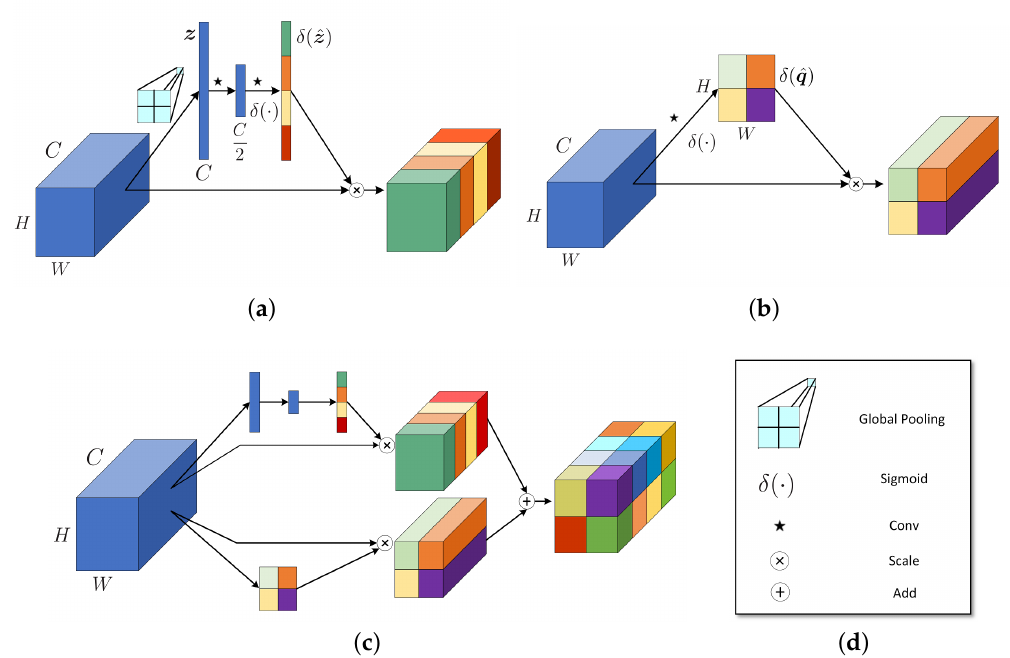
Figure 3. Mechanism of the proposed structure: ( a ) SpectralSE; ( b ) SpatialSE; ( c ) spatial–spectral squeeze-and-excitation (SSSE); and ( d )